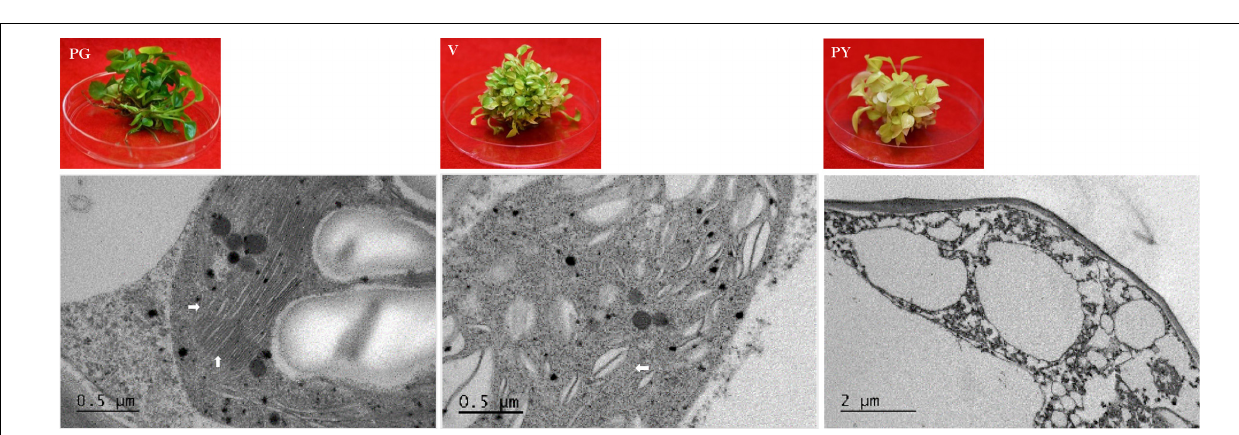
FIGURE 7 | TEM analysis of chloroplast development in ‘Pothos’ transgenic leaf cells. CHL27 transgenic plants from single transformation event with pure green (PG), variegated (V) and pale yellow (PY) leaf colors (left), and TEM (right) of their thylakoids (marked by white